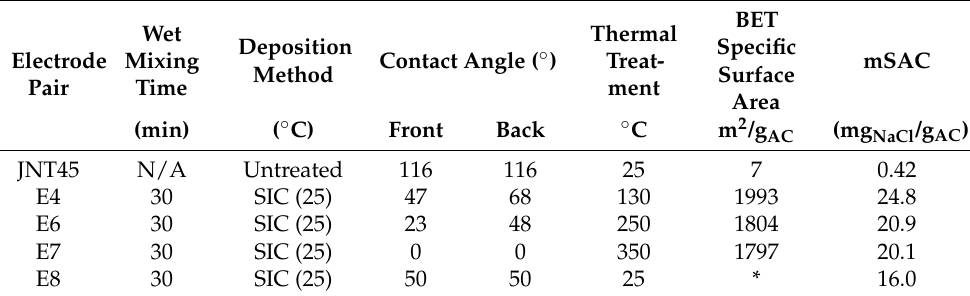
Table 3. Electrodes produced applying slurry infiltration by calendering (SIC), wet mixed for 30 min and thermally treated at various temperatures.